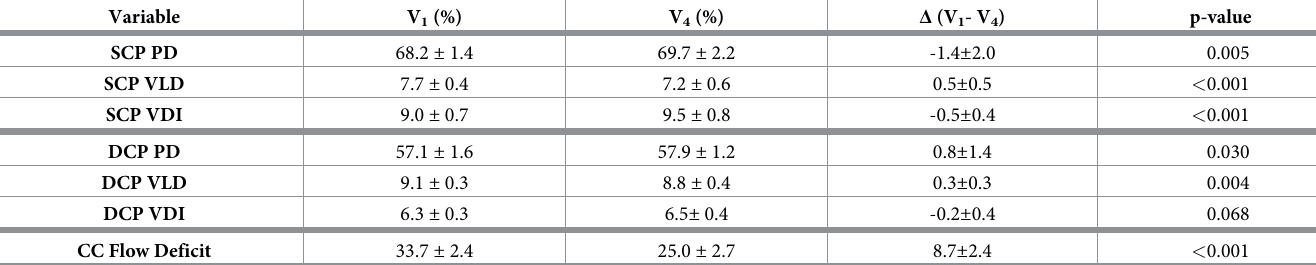
Table 2. Retinal vascular metrics expressed as mean ± SD evaluated for V 1 (%), V 4 (%) and differences.